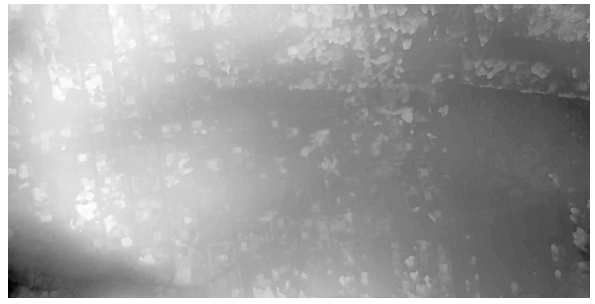
Figure 3: The developed approach through advanced structure from motion, bundle adjustment and dense image matching man- aged to successfully compute a DSM and a true orthophotomo- saic from numerous GoPro